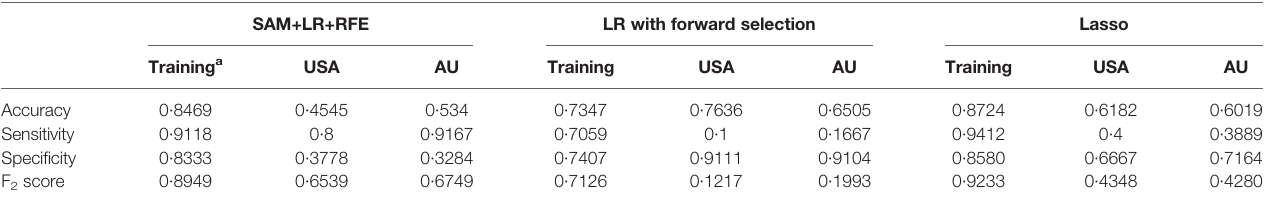
TABLE 3 | The comparison of the prediction performance of different